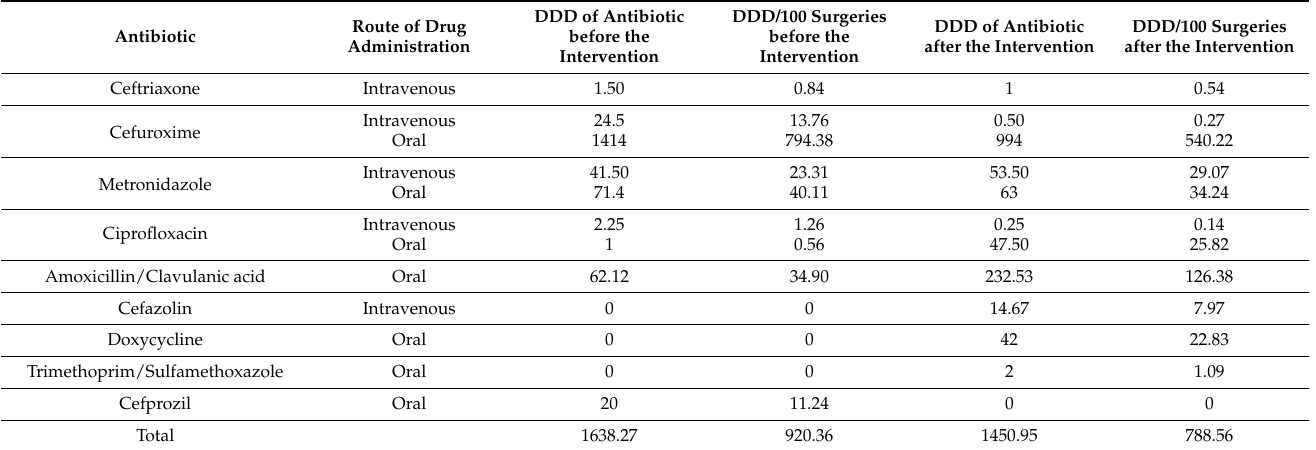
Table 6. Number of patients who were administered different antibiotics before and after the